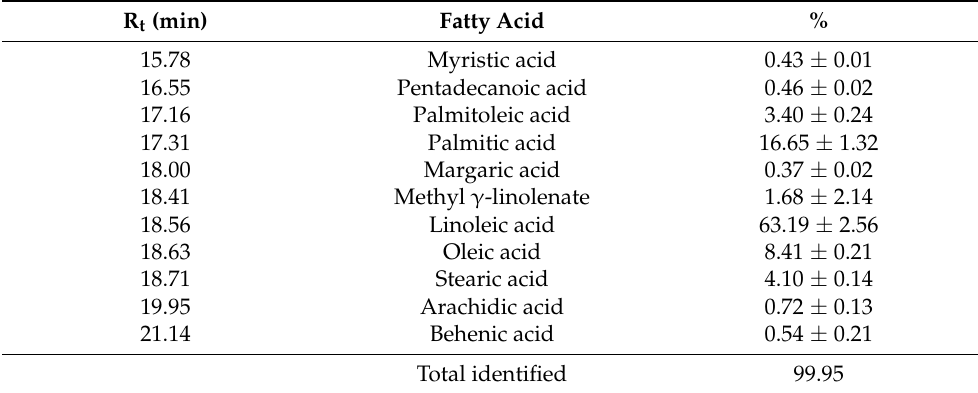
Table 4. GC–MS analysis of almond skin n -hexane